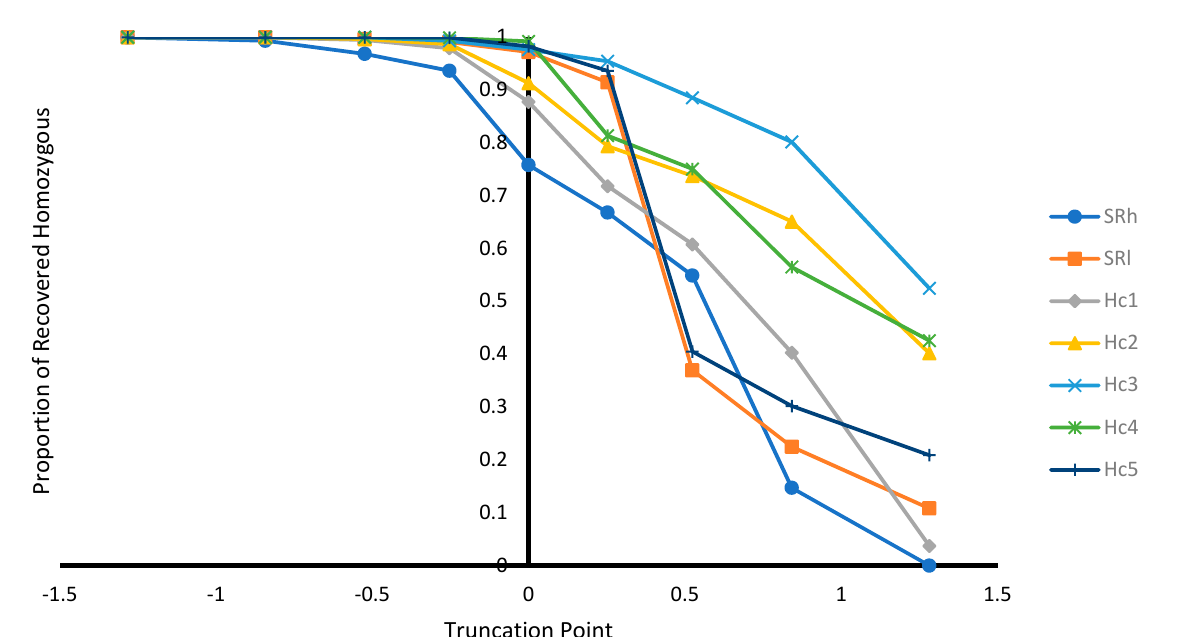
Figure 2. Proportion of recovered homozygous genotypes from the unselected population at different selection truncation points in unit of standard deviations.